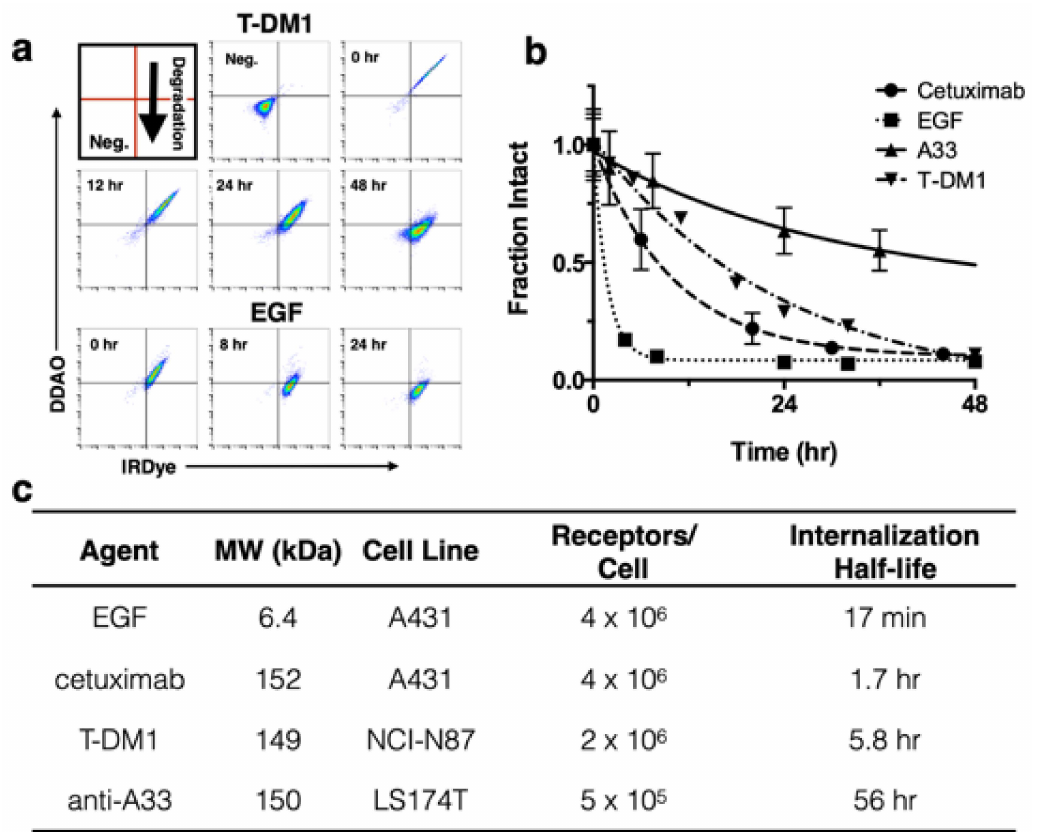
Figure 2. In vitro flow cellular degradation. ( a ) Representative Log-Log flow cytometry plots of dually labeled T-DM1 and EGF gated on cells. Intact protein appears in the DDAO( + ) / IRDye( + ) quadrant. Over time as the biologic is degraded, there is a gradual shift towards DDAO(-) / IRDye( + ). ( b ) Fraction of intact protein for four agents over time. EGF shows rapid internalization and degradation,